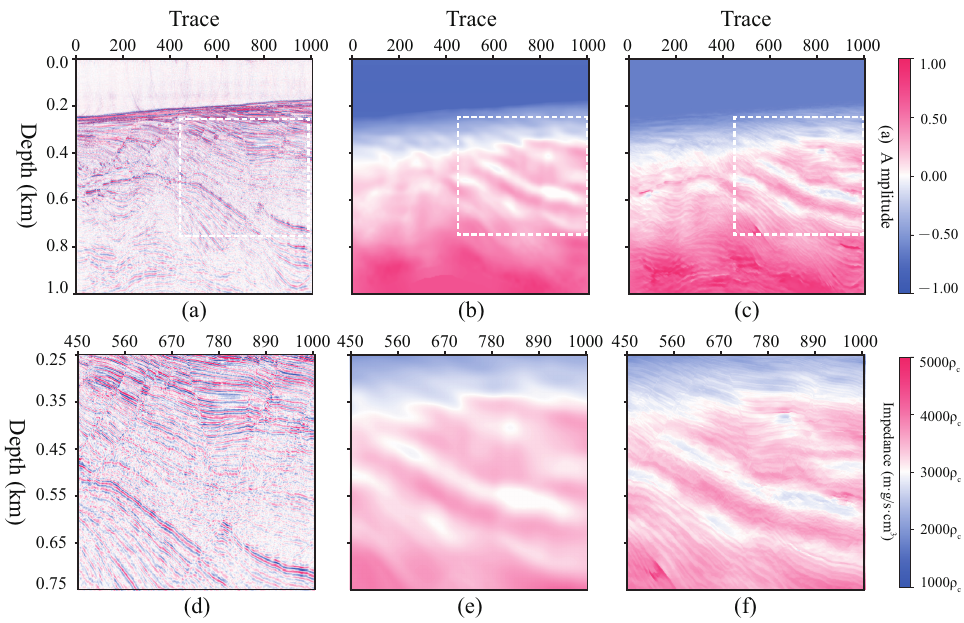
Figure 16. Result of inline No.550 slice. ( a ) The migrations. ( b ) The background impedance with constant density. ( c ) The prediction by self-attention U-Net. ( d – f ) The zoomed-in area of ( a – c ).